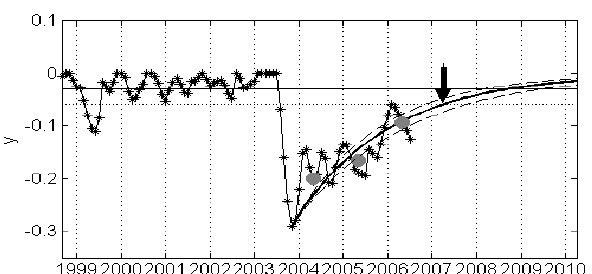
Fig. 5. Time series of observed (lines with asterisks) and modelled (bold curves) values of monthly values of lack of greenness, y , over the large fire scars located in Region I (upper panel) and in Region II (lower panel). The dashed curves indicate the 95% confidence lim- its of the regressed curve and the large grey circles indicate the an- nual means of y . The horizontal dotted line represents the level of vegetation recovery defined as 90% of the mean value of y dur- ing the pre-fire period (represented, in turn, by the horizontal solid line). Arrows indicate the estimated recovery dates, defined as the instant when the modelled curves of y cross the level of vegetation